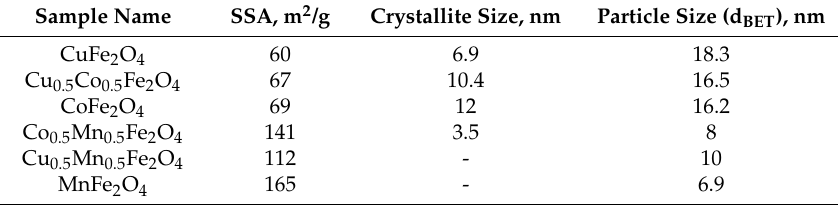
Table 3. Specific surface area (SSA) and crystallite/particle size of spinels with various compositions.